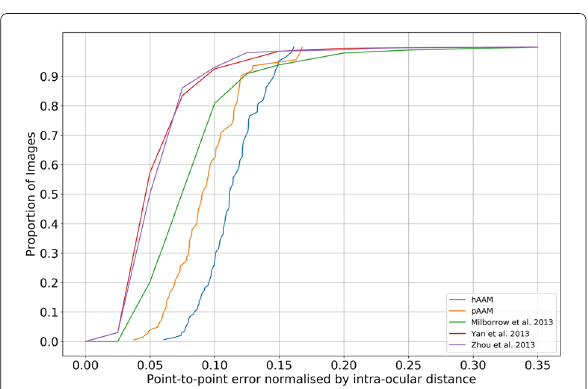
Fig. 12 300W (indoor) cumulative error distributions. Comparing the performance of holistic AAMs, patch AAMs, and the performance reported by Yan et al. [48], Zhou et al. [58], and Milborrow et al. [72]